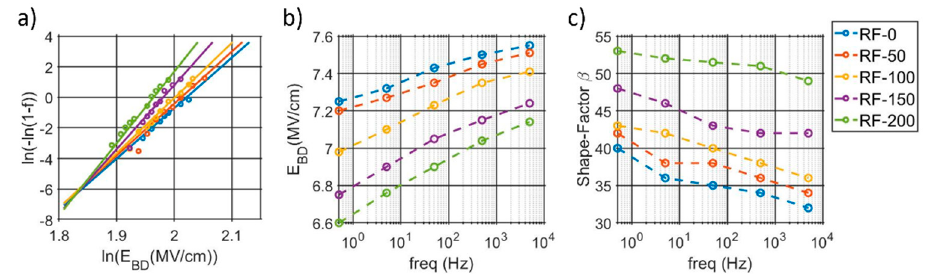
Figure 3. ( a ) Weibull distributions of the breakdown fields with a 5 kHz input voltage for the five samples. ( b ) Average breakdown fields and ( c ) shape factors extracted at different frequencies.